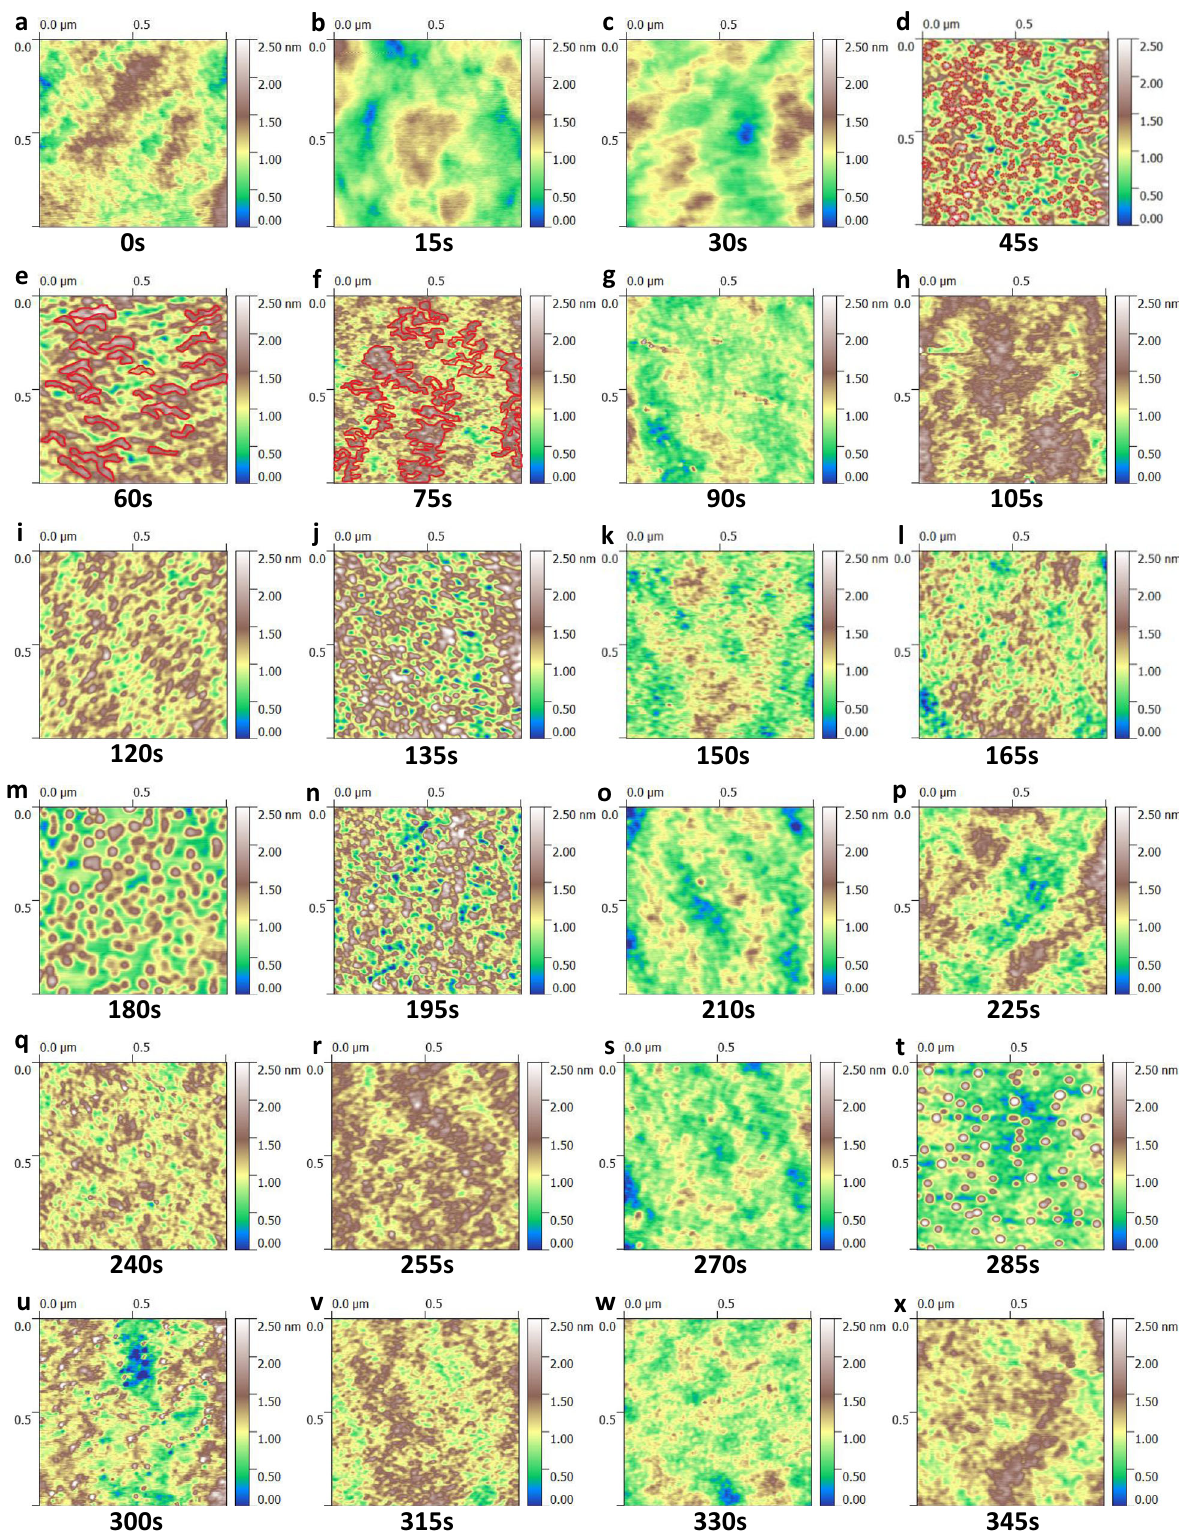
Fig. 1 Surface morphology evolution of Zr 46 Cu 46 Al 8 UMG. a – x show the AFM images taken at different deposition times. The time interval for the images is 15 s, and the UMG was deposited at room temperature (~0.43 T g ) with a deposition rate of 1.07 nm min − 1 . The UMG was deposited on Si 3 N 4 substrate. The red lines in d – f indicate the pro fi les of the islands on the surface. The lateral size of the images is 1 μ